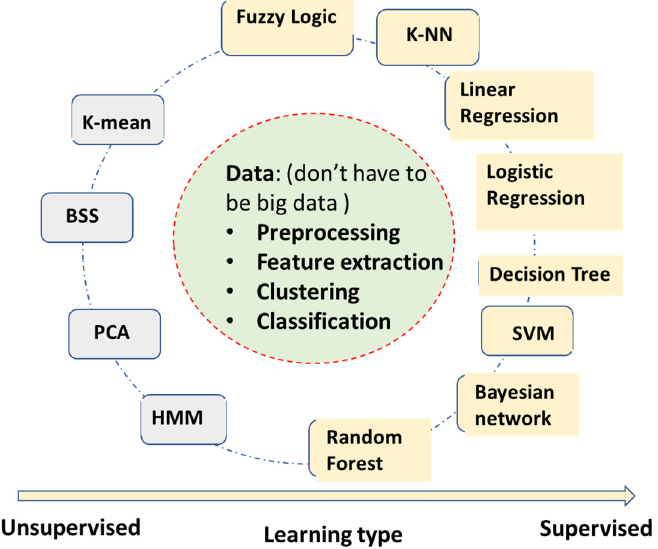
Figure 2. A diagram for the most widely used statistical learning algorithms. Most of the non-deep learning algorithms listed here can work on moderate-sized data since their independent parameters are limited. These algorithms mostly work on previously extracted features, or they can help to identify the best features such as PCA. On the left is unsupervised learning mainly used for clustering and feature optimization; on the right are supervised learning algorithms, requiring pairs of inputs and labels. All these methods have been used widely in AECG applications in the last several decades.